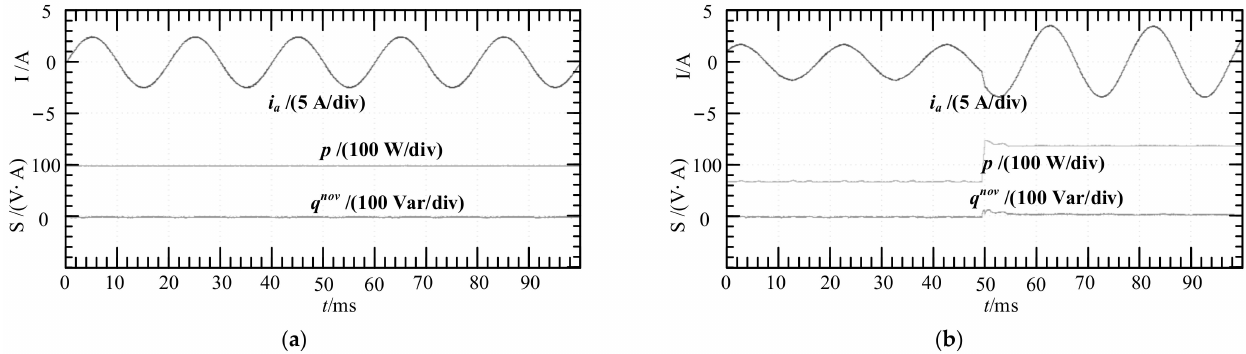
Figure 13. Experimental results of novel FCS-MPDPC under balanced grid voltages; ( a ) steady-state waveform; ( b ) dynamic